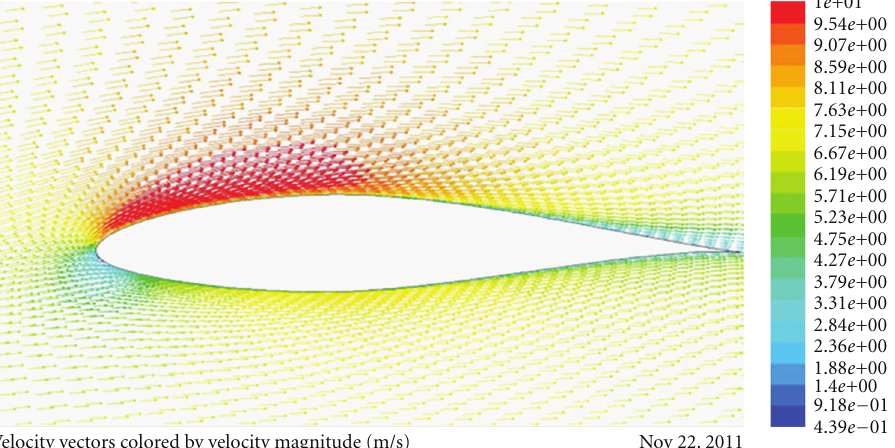
Figure 6: Colour velocity vectors by velocity magnitude around NACA 64-421 airfoil at α = 6 and Re =